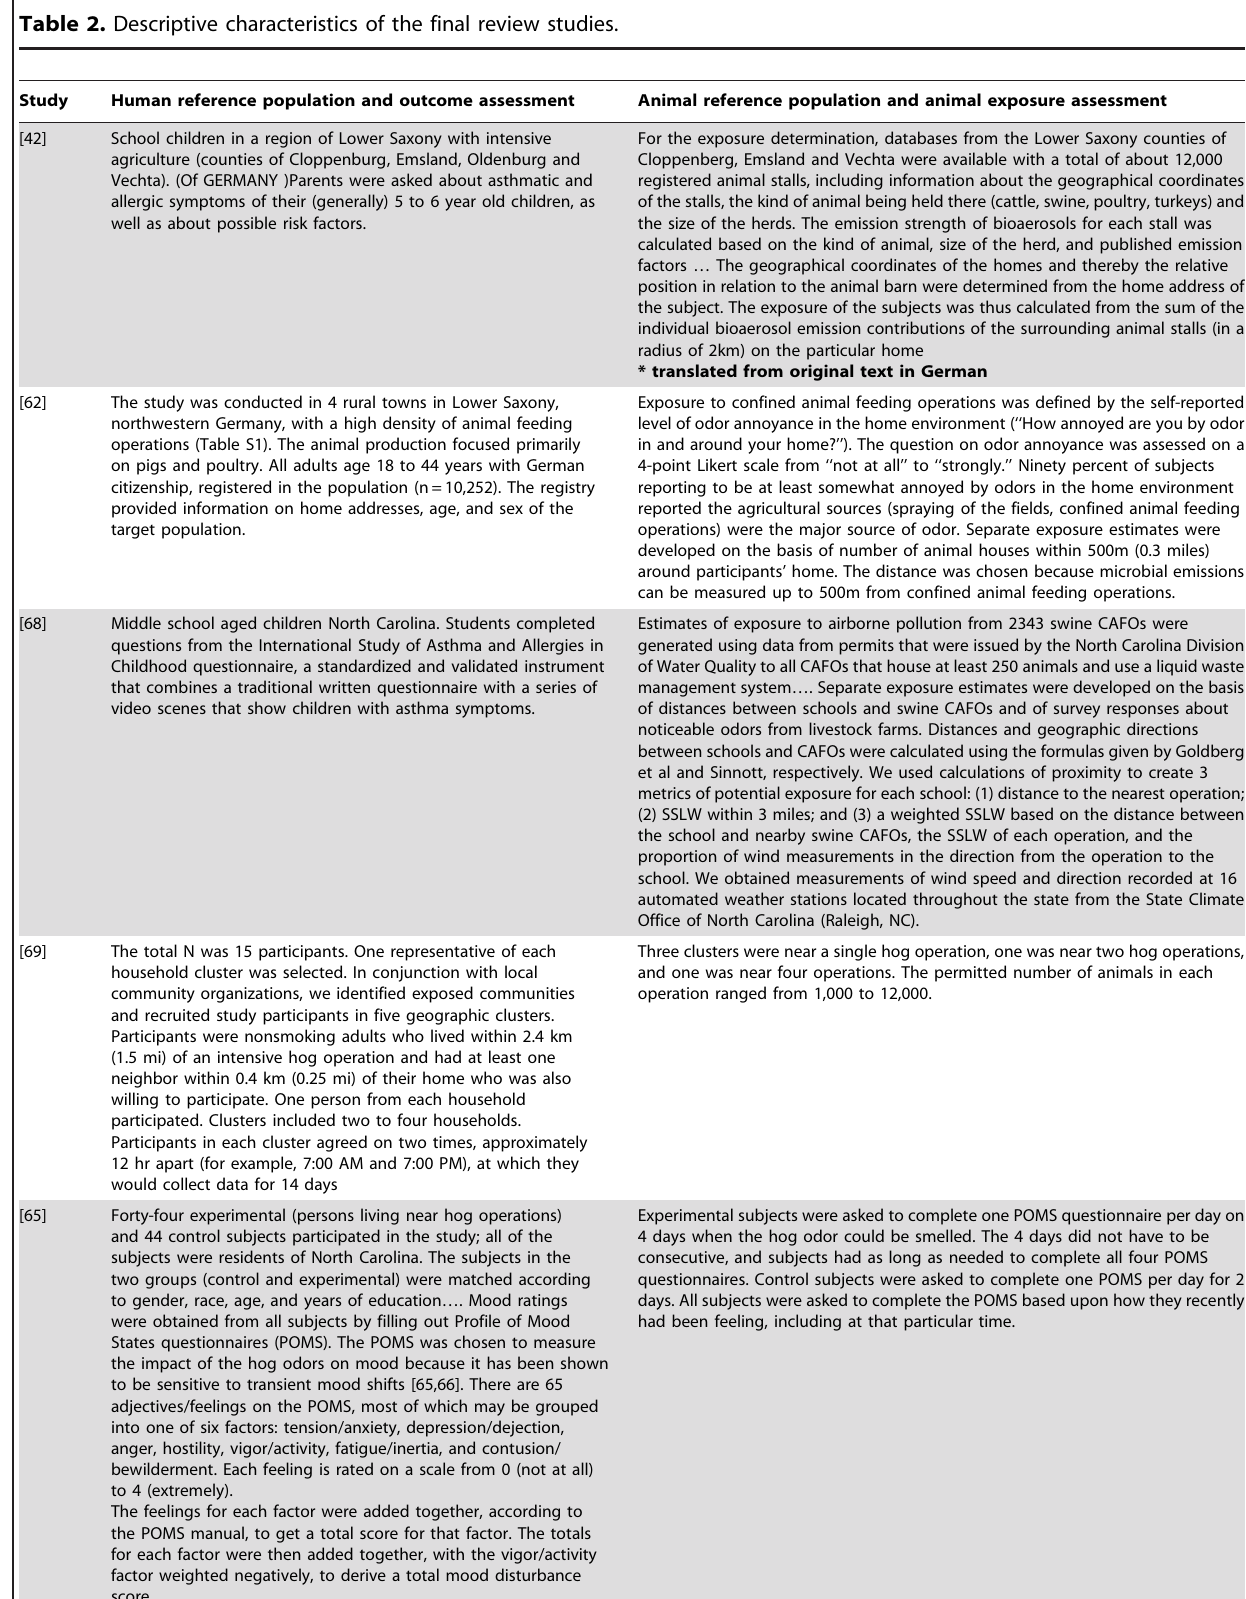
Table 2. Descriptive characteristics of the final review